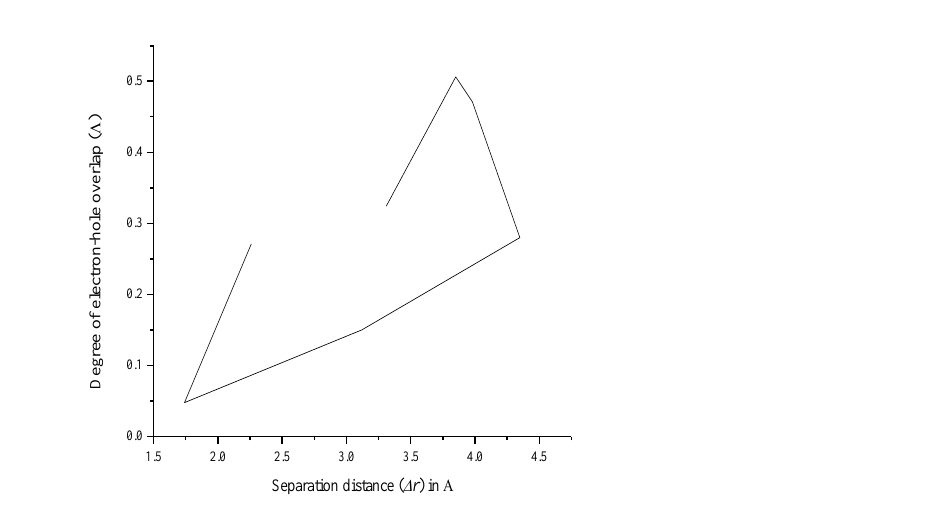
Figure 7. Graphical relationship between electron–hole separation distance and degree of electron–hole overlaps for the orbital pair within each compound.